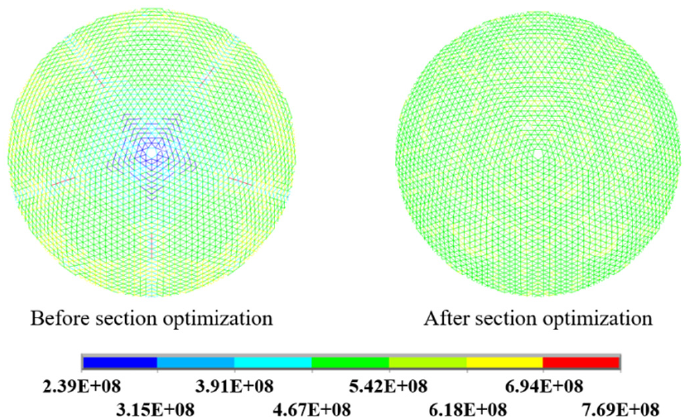
Figure 9. Stress nephogram of main cables.